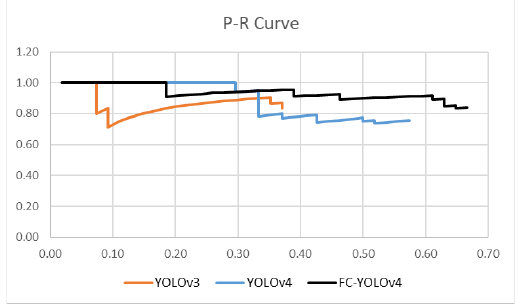
Figure 15. P-R curve. Table 7. Comparison of parameters, detection time, accuracy, and size of three models. Total Parameters